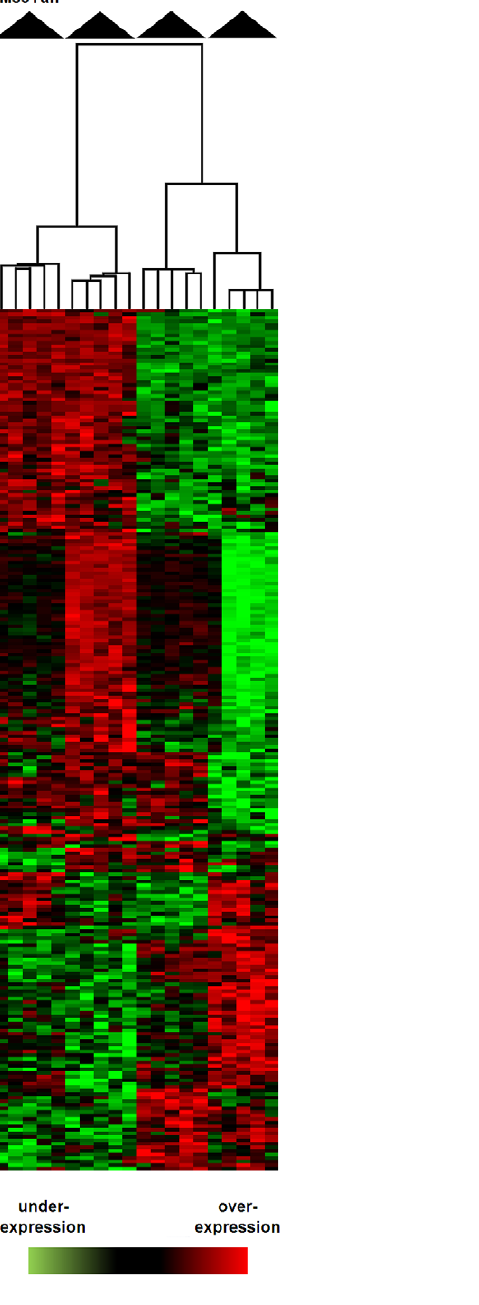
Figure 4. Clustering derived from statistically deregulated genes in Ts65Dn, Ms5Yah, and Ts65Dn/Ms5Yah. Whole genome microarray expression analysis was performed on RNA isolated from whole adult mouse hearts and statistically deregulated genes were assessed using GeneSpring software. Clustering showed proximity between Ts65Dn/Ms5Yah and Ts65Dn arrays on one side, and between wt and Ms5Yah arrays on the other side. Under-expression and over- expression are represented in green and red respectively, expression levels were calculated by comparison to mean expression level of all arrays for each gene.